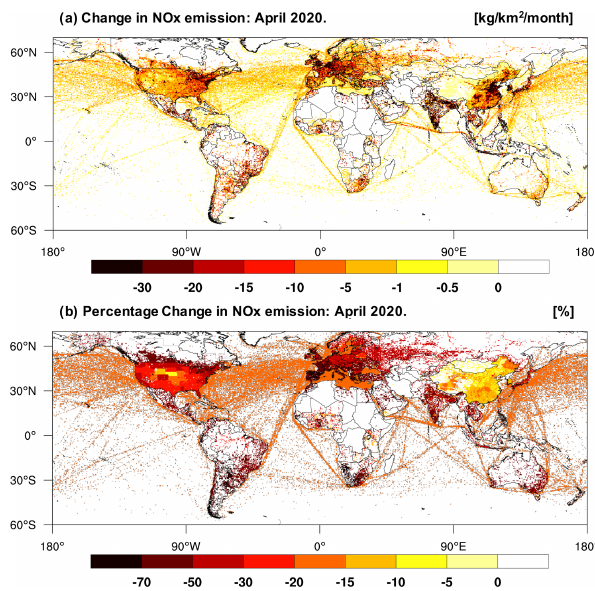
Figure 9. Spatial distribution of (a) the absolute change and (b) the percentage change in total NO x emission (combination of emis- sions from ground transportation, industry, power, residential and shipping) for April